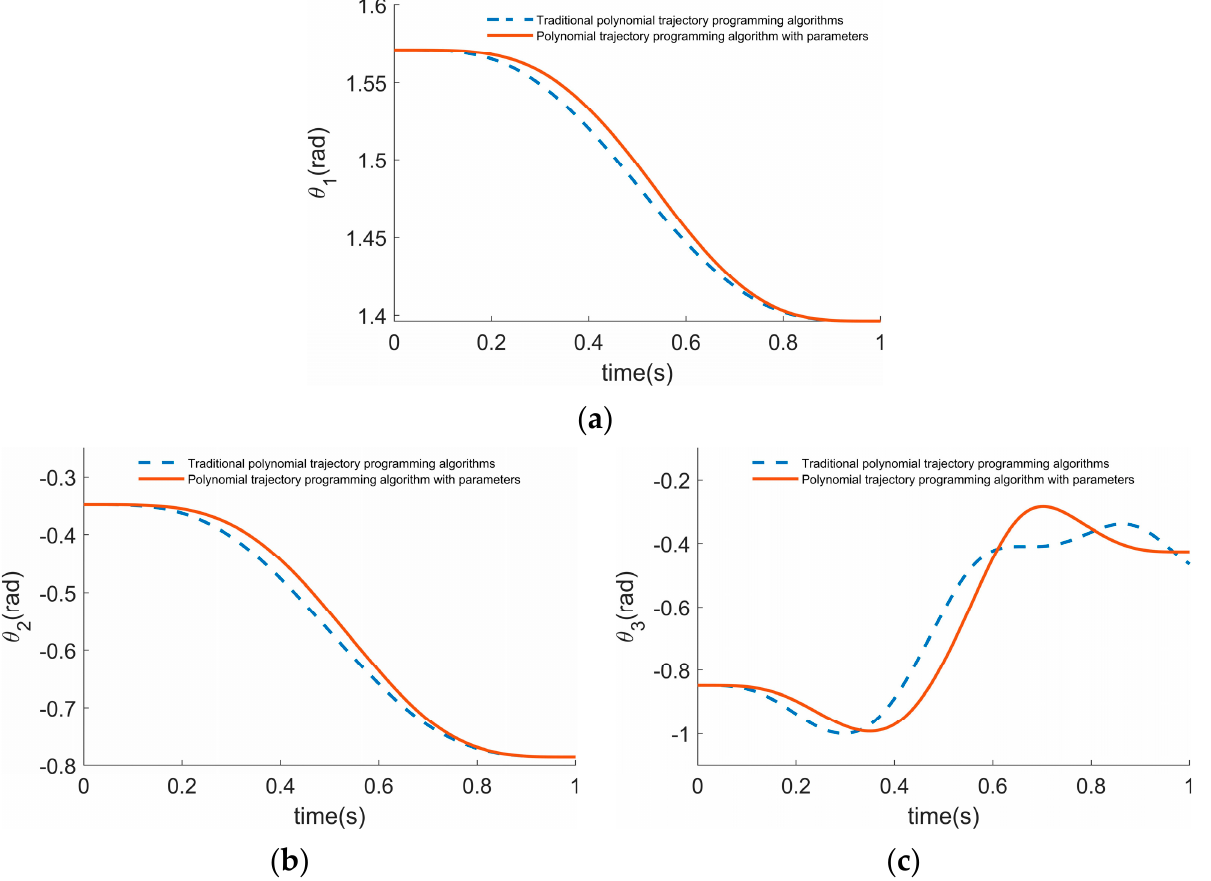
Figure 9. Trajectory joint angles solved under the two planning algorithms. ( a ) Comparison of θ 1 − angle; ( b ) Comparison of θ 2 − angle; ( c ) Comparison of θ 3 − angle.